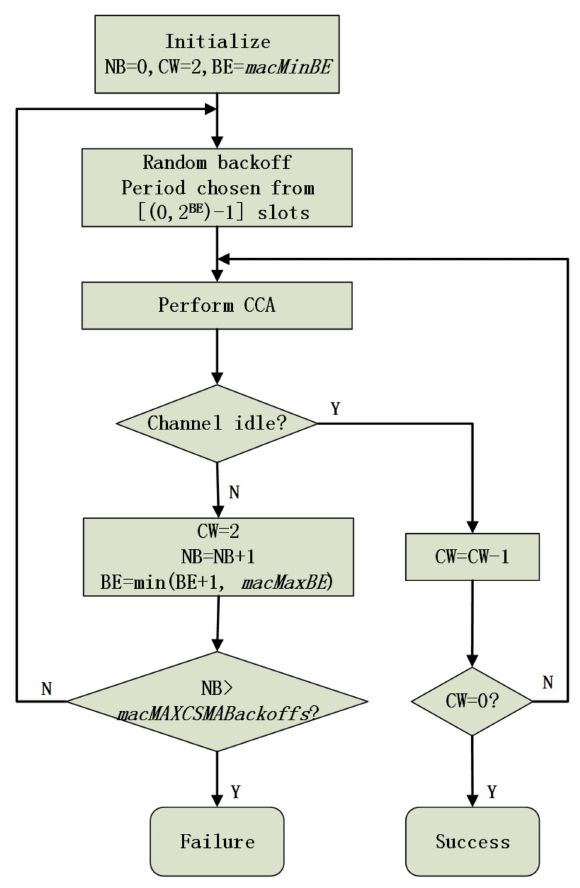
Figure 2. Slotted CSMA / CA